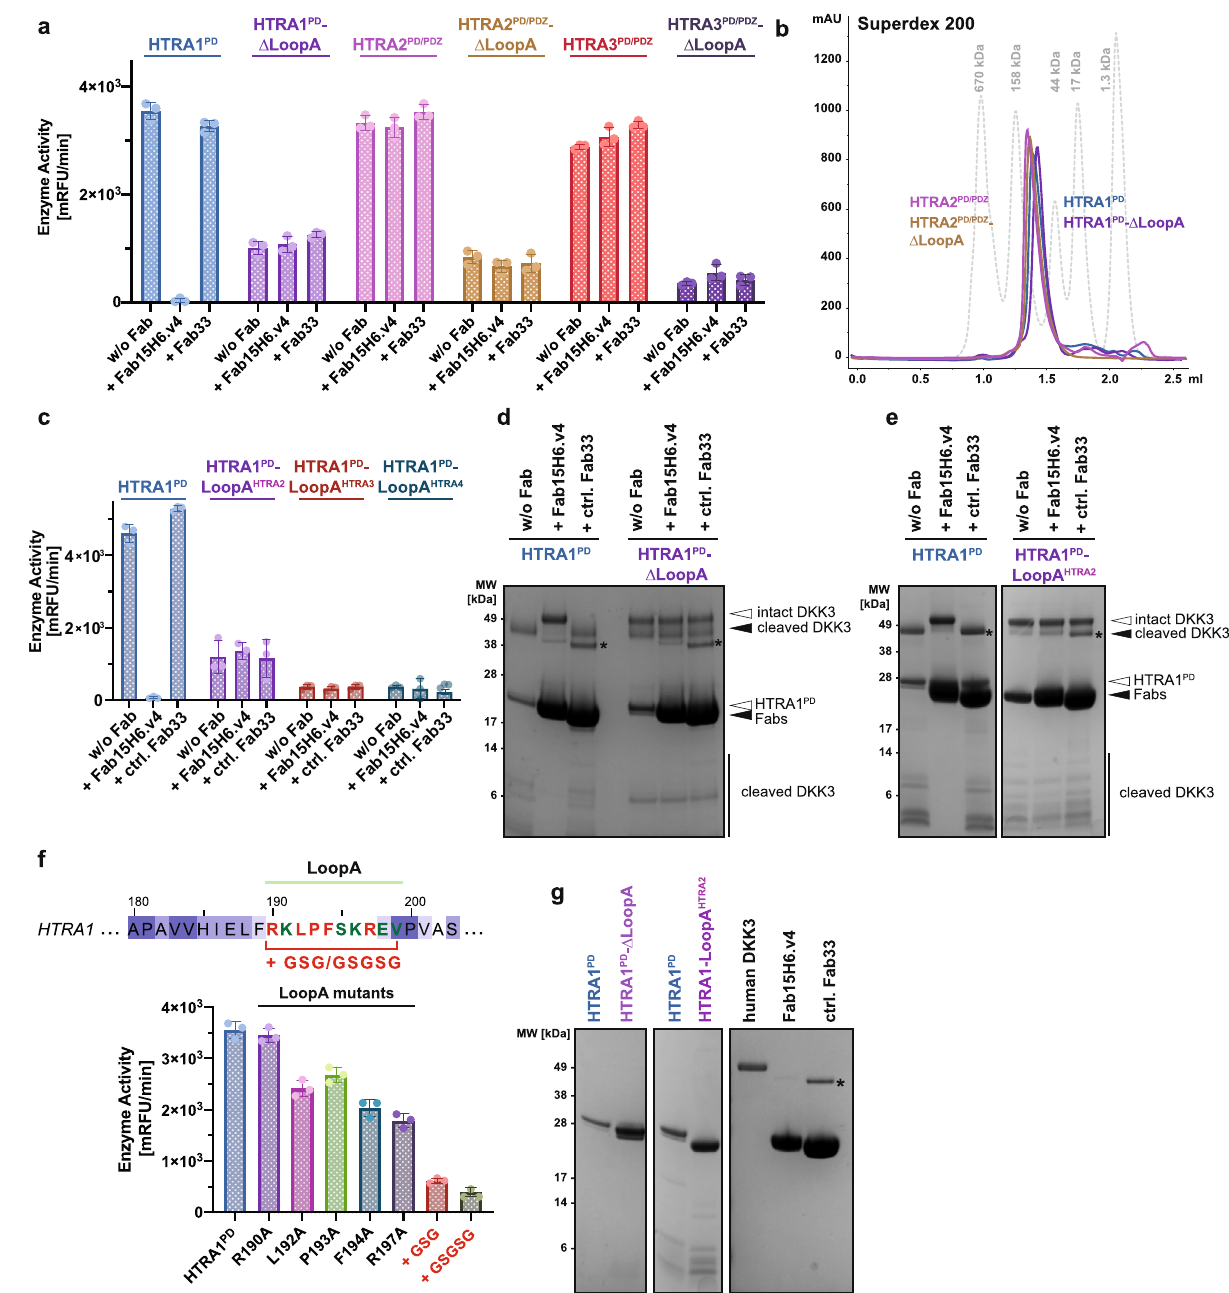
HTRA1 PD -LoopA HTRA2 . f Design and enzymatic activity of single amino acid sub- stitutions within LoopA of HTRA1 PD and of GSG/GSGSG linkers. g Control gels showing individual proteins incubated under identical conditions as used for cleavage assays in d , e Asterisk (*) in ( d , e , g ) indicates contaminant in the Fab33 preparations that overlaps with the cleaved DKK3 band. Bar graphs in a , c , f are presented as the mean±S.D. of three independent experiments. Images in d , e , g as well as chromatogram in b are representative of two independent experiments. For experiments in a , b the HTRA2 and HTRA3 constructs com- prised the protease and PDZ domains (HTRA2/3 PD/PDZ ). Source data are